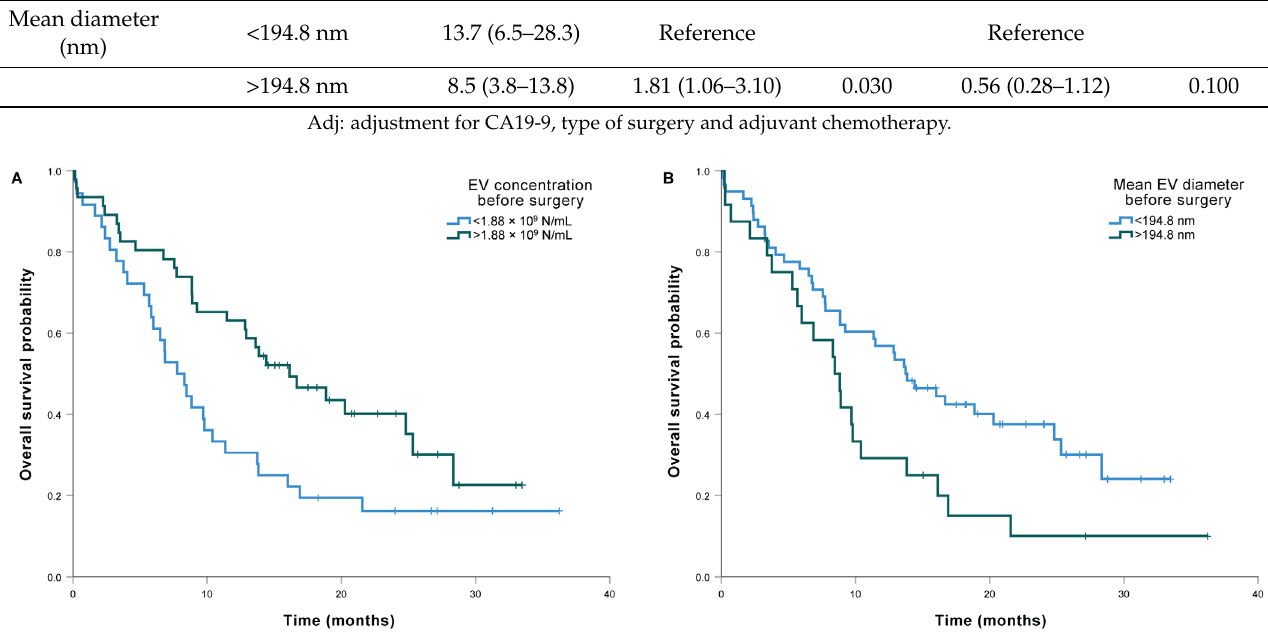
Figure 3. OS of patients with PDAC according to preoperative sEV characteristics. ( A ) Association of sEV concentration before surgery with OS. If sEV concentration was more than 1.88 × 10 9 /mL, patients had longer OS. ( B ) Association of sEV mean diameter with OS. If sEV mean diameter was less than 194.8 nm, patients had longer OS. Censored patients are presented with a vertical line.